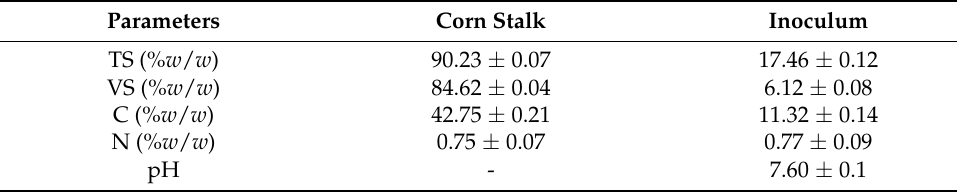
Table 1. Physicochemical properties of corn stalks and inoculum.